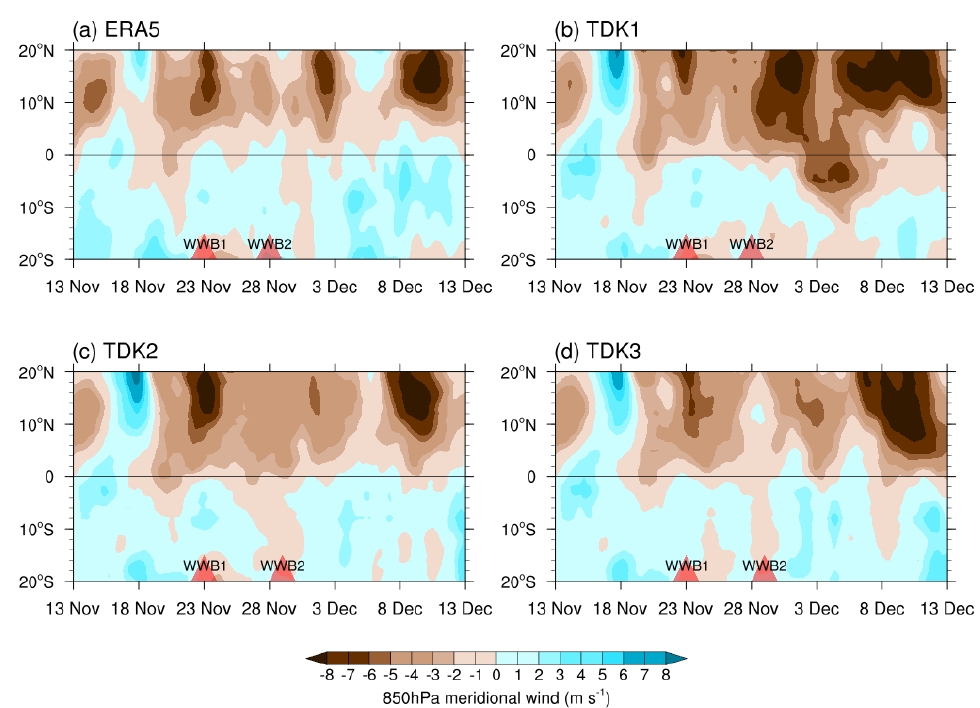
Figure 9. Time-latitude diagrams of 850 hPa meridional wind (m s −1 ) over the analysis domain (10° N – 10° S, 105° E – 120° E) for ( a ) ERA5, ( b ) TDK1, ( c ) TDK2, and ( d ) TDK3 experiment from 13 November to 13 December 2011. The red triangles present the time ranges when the WWB1 and WWB2 convective centers are located near 90° E.